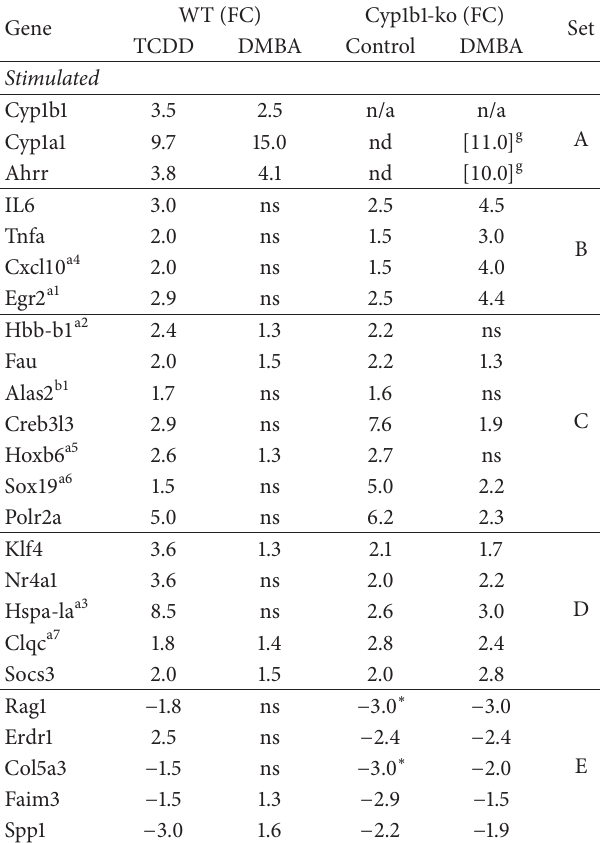
Table 1: Genes targeted by Cyp1b1 endogenous substrates and AhR. Separation by DMBA